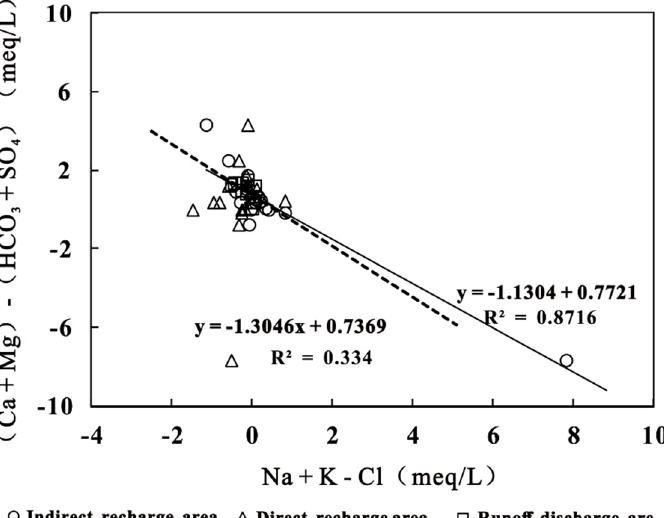
Figure 6. (Ca + Mg) − (HCO 3 + SO 4 ) vs. Na + K − Cl scatter plot of karst water from the Baotu karst spring system.